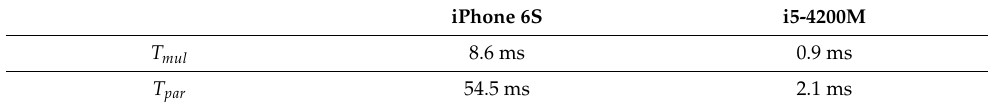
Table 4. Computational terms in cryptographic operation in two frameworks.